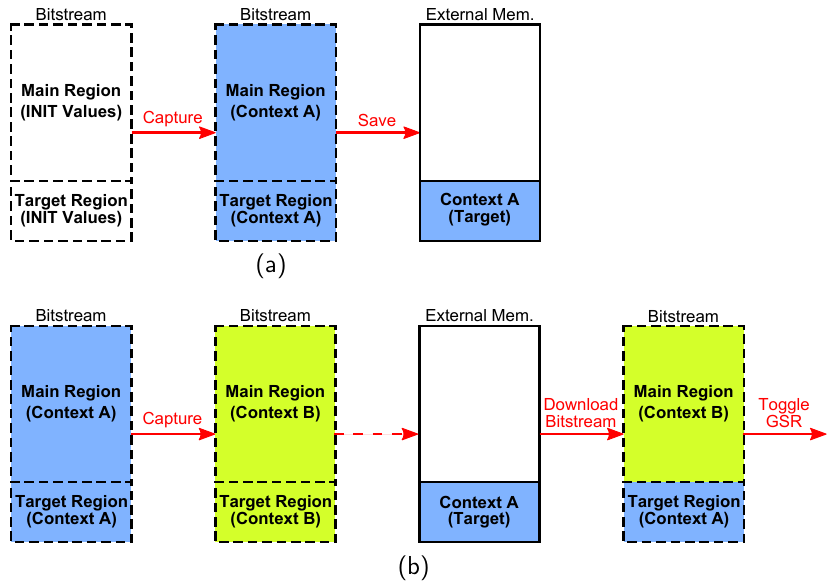
Figure 3. Context save ( a ) and restore ( b ) approach for 7 series devices with external